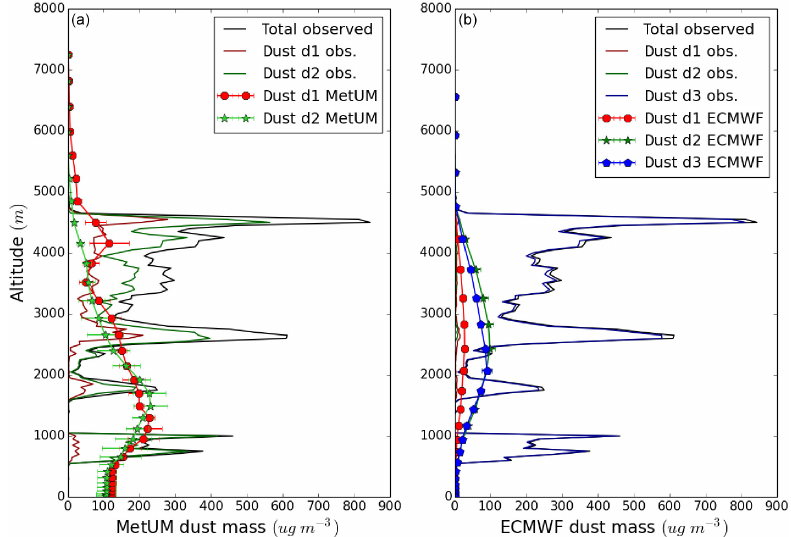
Figure 5. Case study 1, B920, 7 August, P1. (a) Dust concentration measured by the in situ instruments on the aircraft for MetUM dust divisions 1 (red) and 2 (green), as well as the total dust concentration measured (black). The division 1 and 2 concentration from the model is shown in a lighter shade of red and green, respectively, with markers and error bars showing the standard deviation. (b) The right-hand plot shows the same thing but for the ECMWF–CAMS size bins, with the measurements shown using lines and the model values with lines and markers for divisions 1 (red), 2 (green), and 3 (blue). See text for the description of the